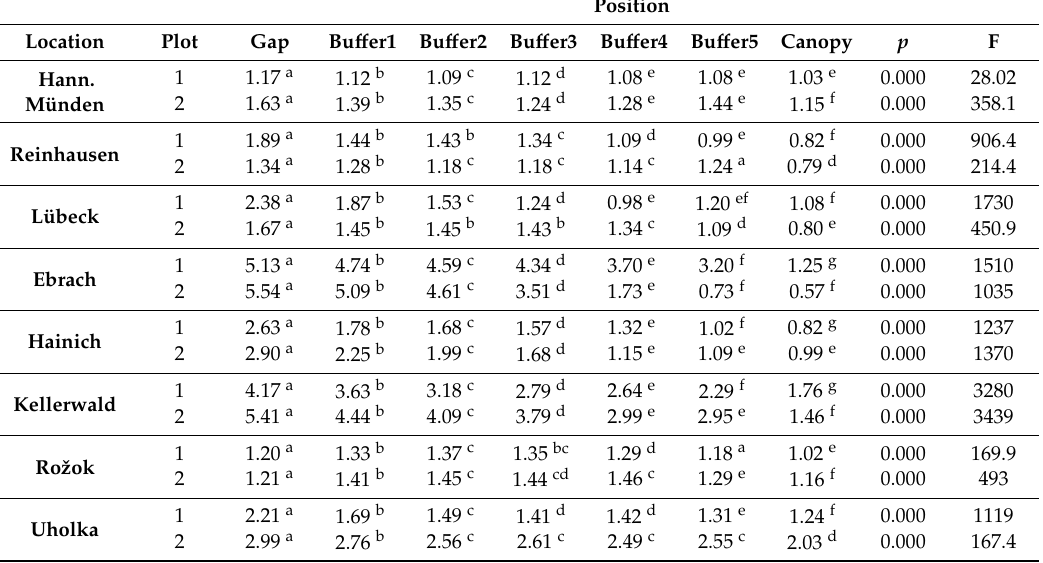
Table 3. Mean regeneration height depending on the position of the regeneration area from within-gap over transitional bu ff er zones to closed-canopy. Di ff erent lower-case letters indicate significant di ff erences between positions at the level of p < 0.05. The degrees of freedom in all statistical tests were six. Column “ p ” lists the p -values that indicates the significance of the test results. The F-value in column “F” indicates the value of the F-distribution used to calculate the p -value.